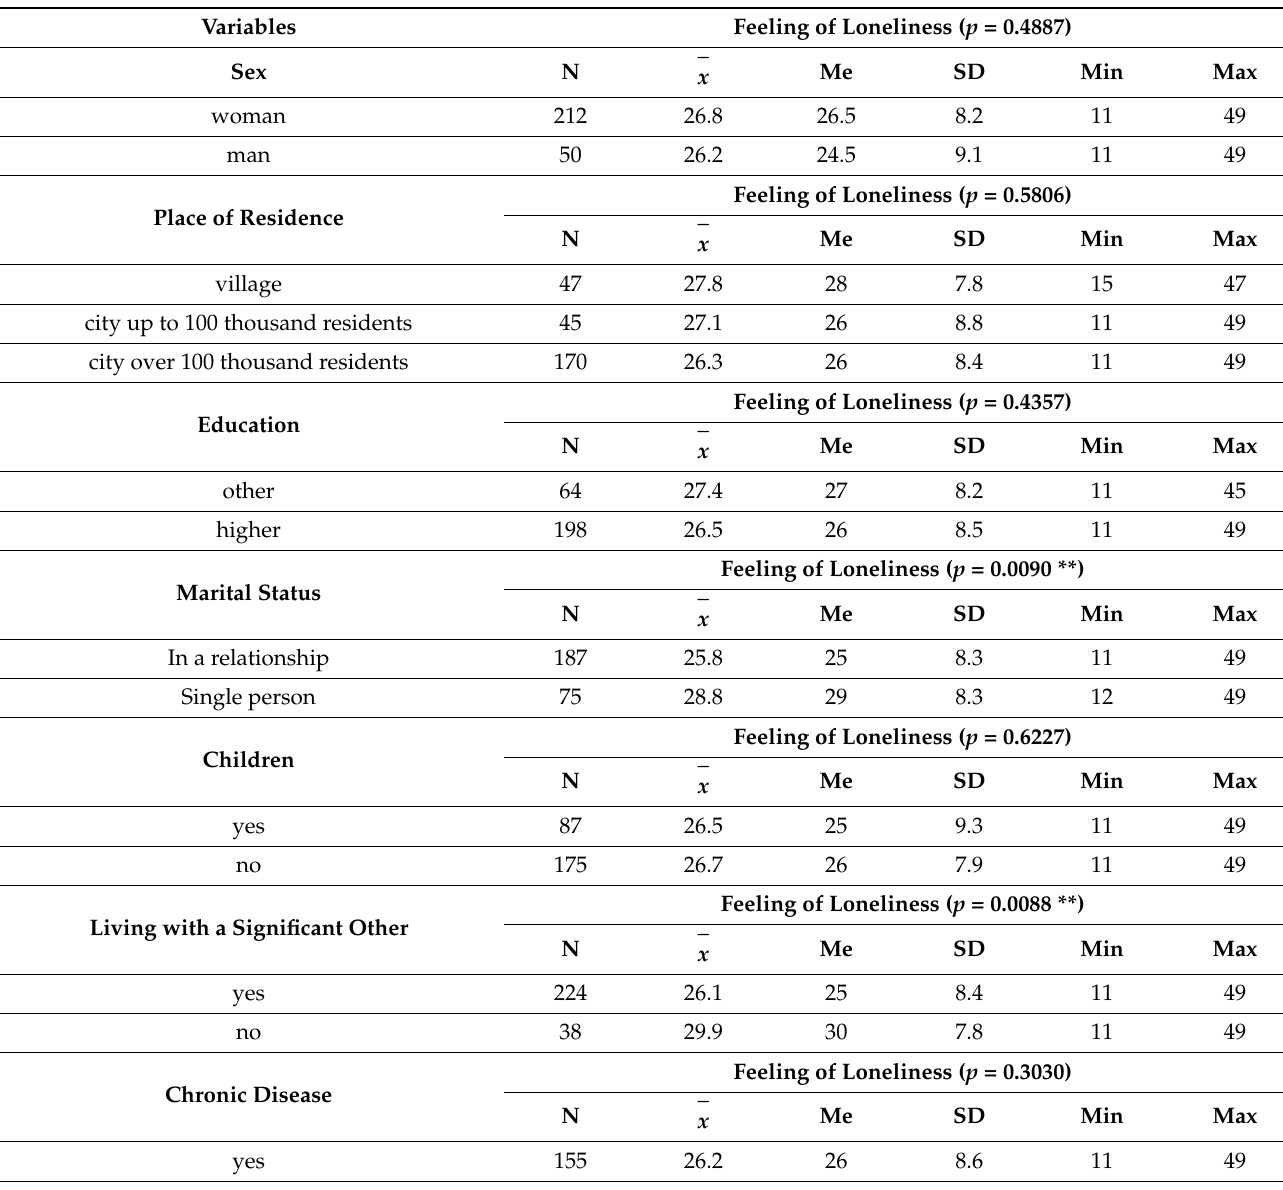
Table 4. A sense of loneliness in connection with sociodemographic